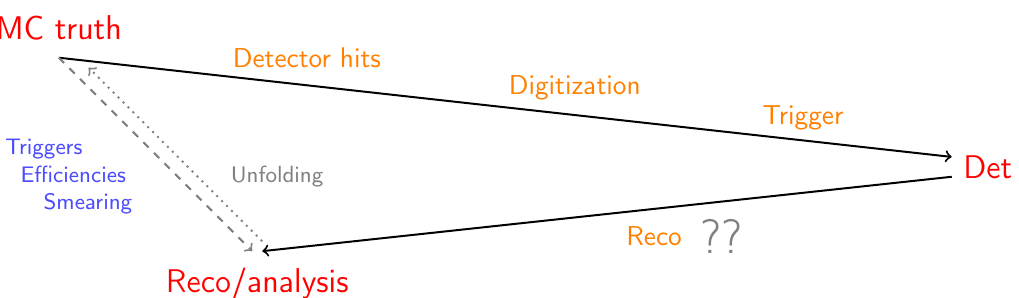
Figure 1: Smearing vs. explicit fast-simulation strategies compared, showing how a smearing approach short-circuits the little-known major effects of the detector and reconstruction processes individually, by instead parametrising the resultant relatively small effect of detector + reconstruction. The axes are arbitrary, but distances between points on the two trajectories represent the typical size of discrepancies between equivalent physics objects at the two stages of